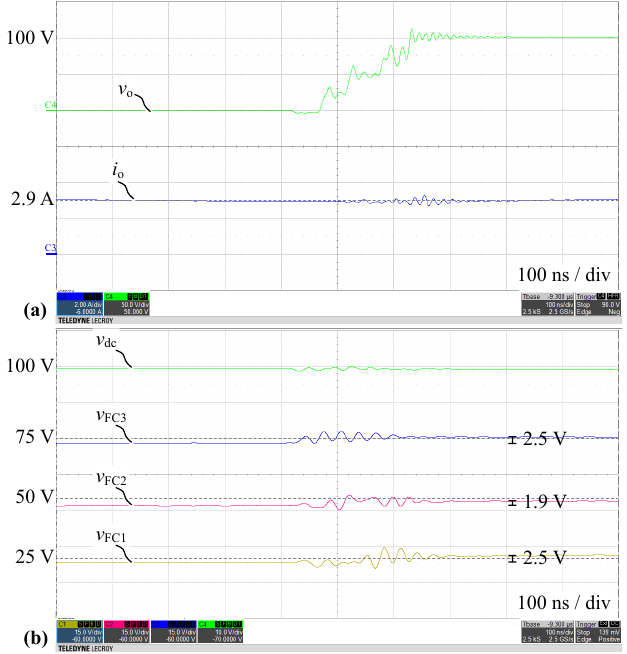
Figure 12. Measured waveforms for Q2L-5L-FCC in configuration 2 (cid:13) with positive output current ( i o = 2.9A) during the switching transition with positive slope of v o , which results in a HS transition: ( a ) Output voltage v o and current i o , ( b ) DC-link capacitor voltage v dc and FC voltages v FC{1,2,3} . A delay time of T delay = 50ns is used.